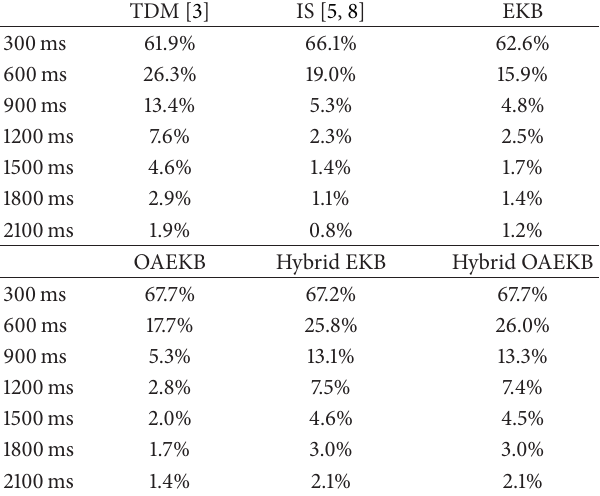
period of time. The IS assumes that the player will maintain